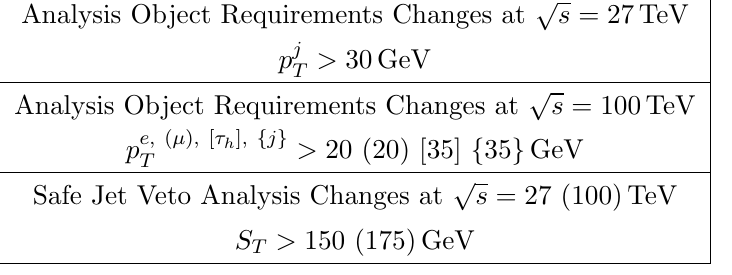
Table 8. Relative to table 6, the changes to the analysis object requirements at (top) p s = 27 TeV and (middle) p s = 100 TeV; (bottom) changes to the safe jet veto analysis at p s = 27 (100) TeV. reduces signal acceptance, as see in (cid:12)gure 14. Quantitatively, we see a uniform reduction in sensitivity by nearly a factor of 2 with respect to the cLFV cases. This is due to (cid:2)